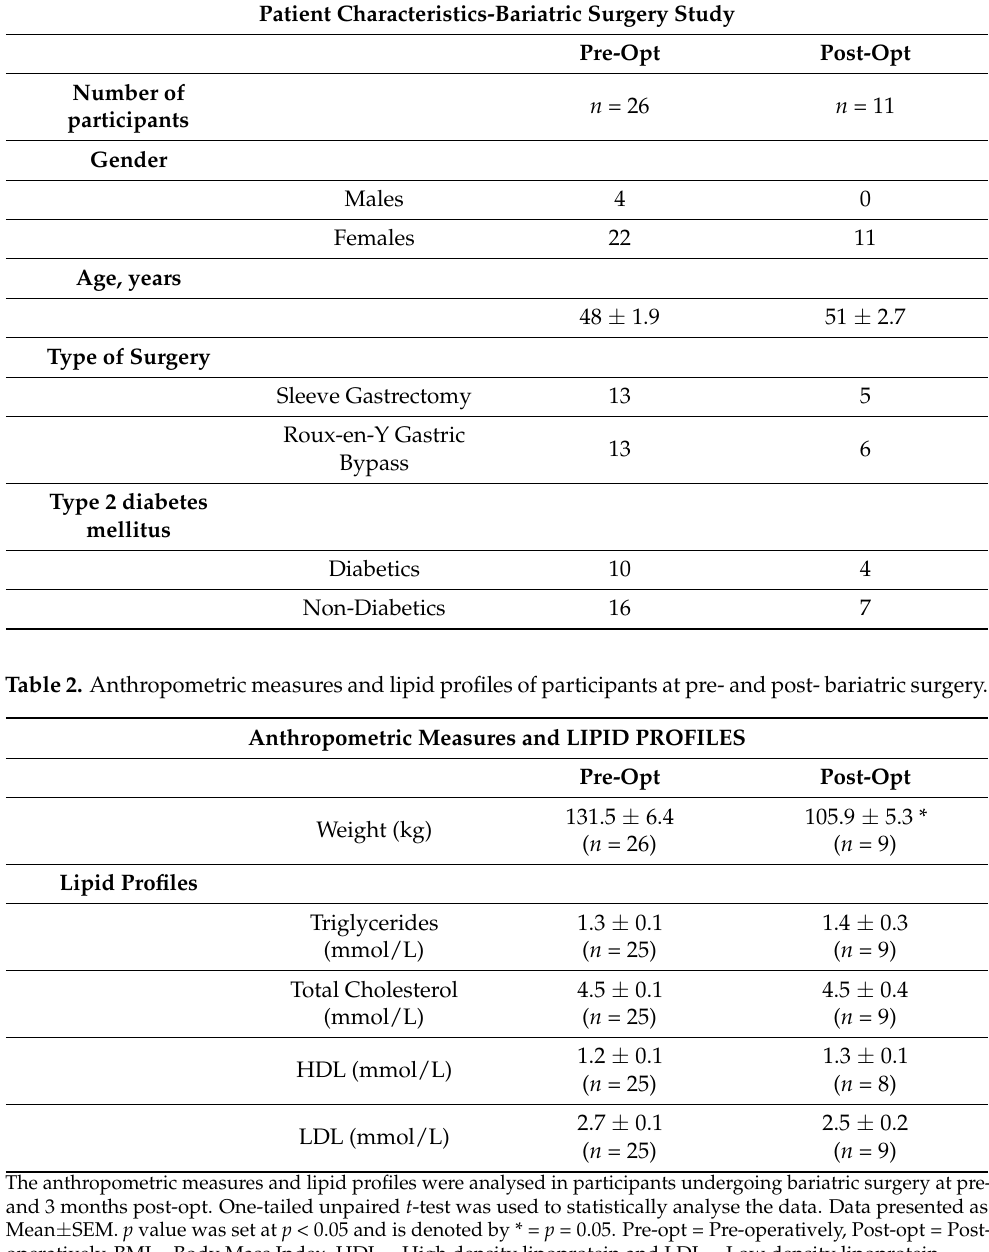
Table 1. Participant characteristics at pre- and post- bariatric surgery. Pre-opt = Pre-operatively and Post-opt = Post-operatively.